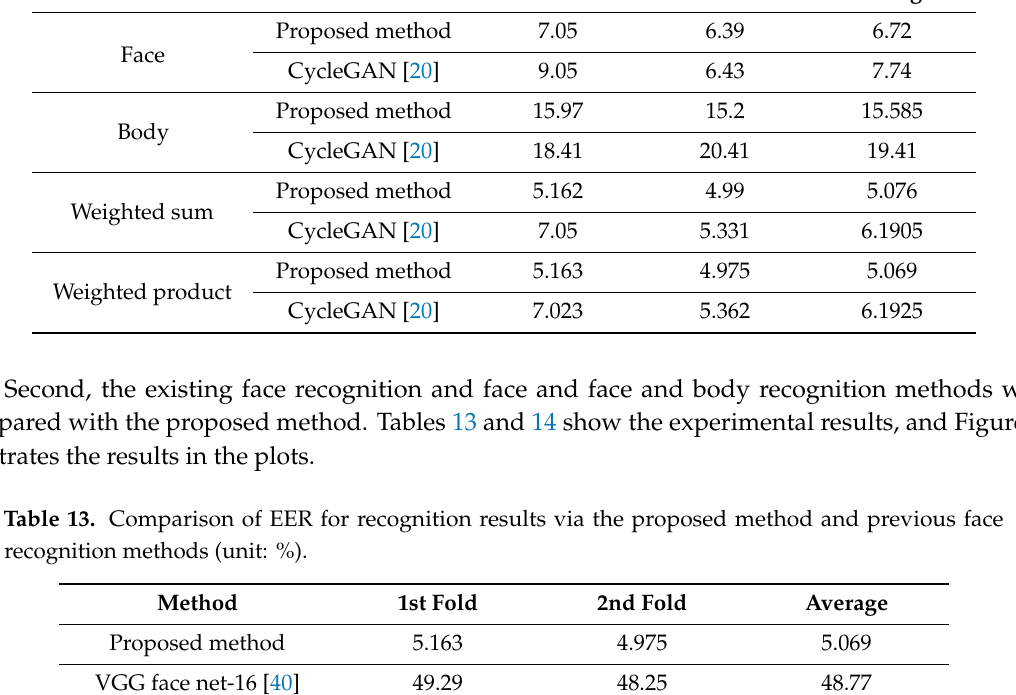
Table 13. Comparison of EER for recognition results via the proposed method and previous face recognition methods (unit: %).